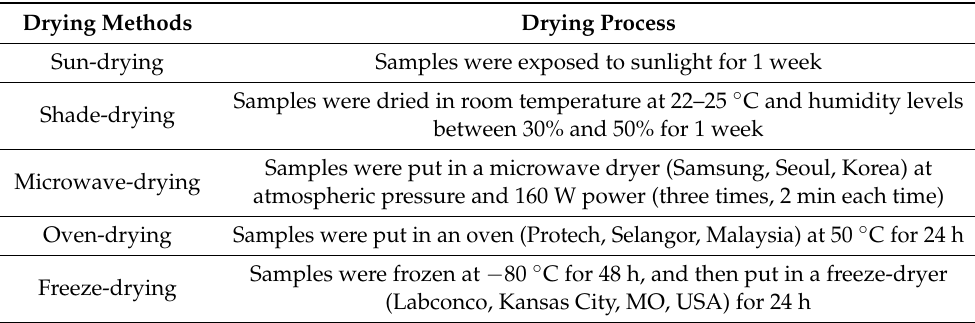
Table 12. Summary of the drying methods applied to the sample leaves. Drying